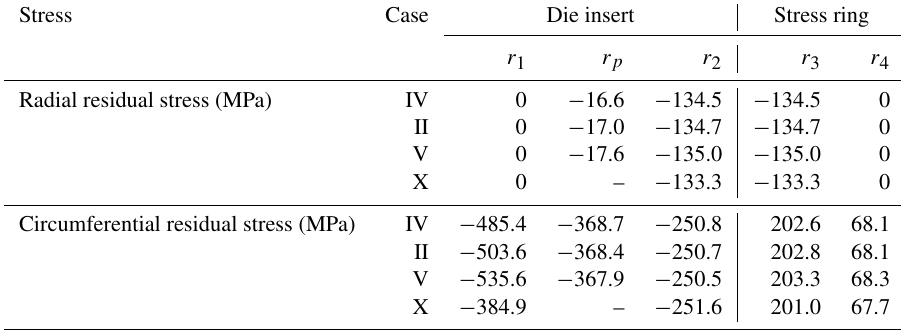
Table 5. Residual stresses in cases with different yield